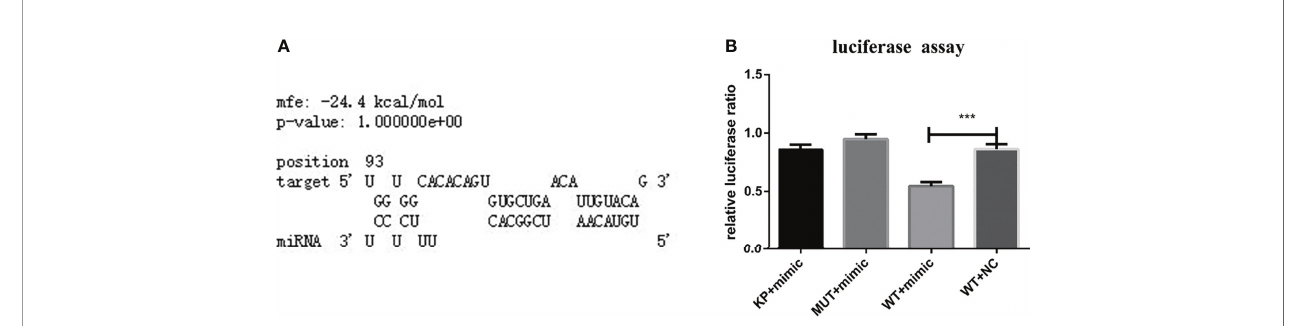
FIGURE 2 | (A) TAB2 was identi fi ed based on predictions of a binding site for nov-mir-17 in this experiment using RNAhybrid software. (B) TAB2 is a target of nov- miR-17. Dual luciferase reporter assay results are presented as the means ± SEMs of triplicate